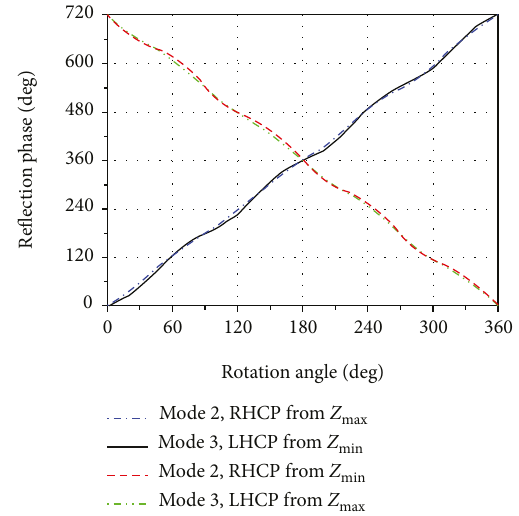
Figure 7: Phase curves of the dual-mode CPSS cell for LHCP and RHCP plane-wave incidences from both sides of the cell at mode 2 and mode 3. Phase response for di ff erent angles of incidence for TE